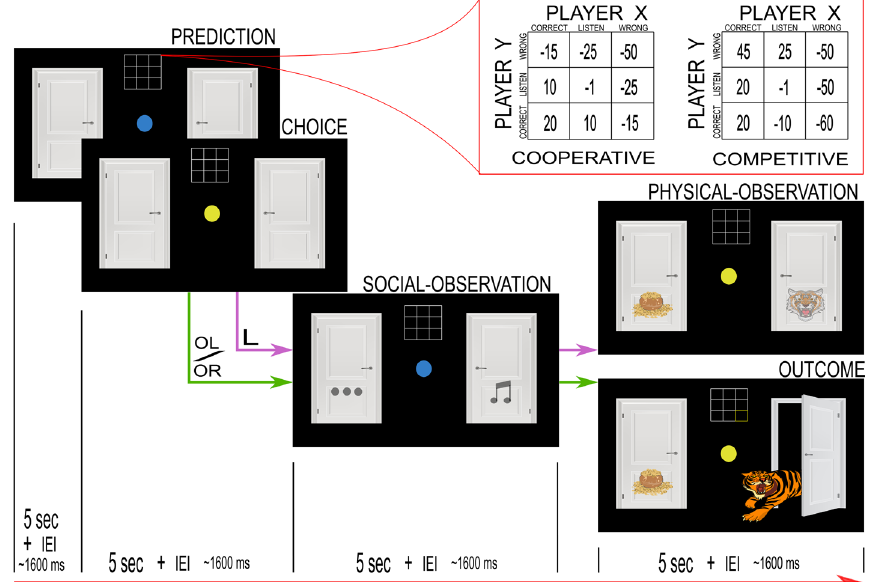
Figure 3. Task sequence of the multiagent version (cooperative and competitive context) of the interactive tiger task (ITT). The task sequence was color-coded for the participant. Blue represented the other participant and yellow represented self. The participant began each round of the task by predicting the action choice of the other participant (PREDICTION). The participant had 5 seconds. After an inter-event-interval (IEI) of ∼ 1600 milliseconds, the participant had to make the personal action choice (CHOICE) within 5 s. Regardless of the one’s own action, the participant obtained probabilistic ( 80% correct) social information (SOCIAL- the locations of the tiger and the pot of gold (PHYSICAL-OBSERVATION) for Listen (L) action, or opening the door (OUTCOME) for open left/right (OL/OR) actions, to get the gold-pot/tiger (tiger encounter is shown in the figure). Opening the door randomly reallocated the tiger and the reward locations to begin the tiger-trial sequence again. The permanent context-specific matrices in the red box show the potential payouts for the participant (player X) during interaction with the other (player